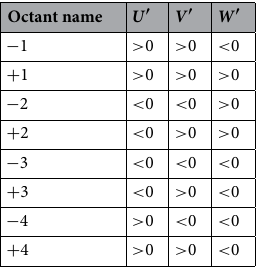
Table 2. Determination of